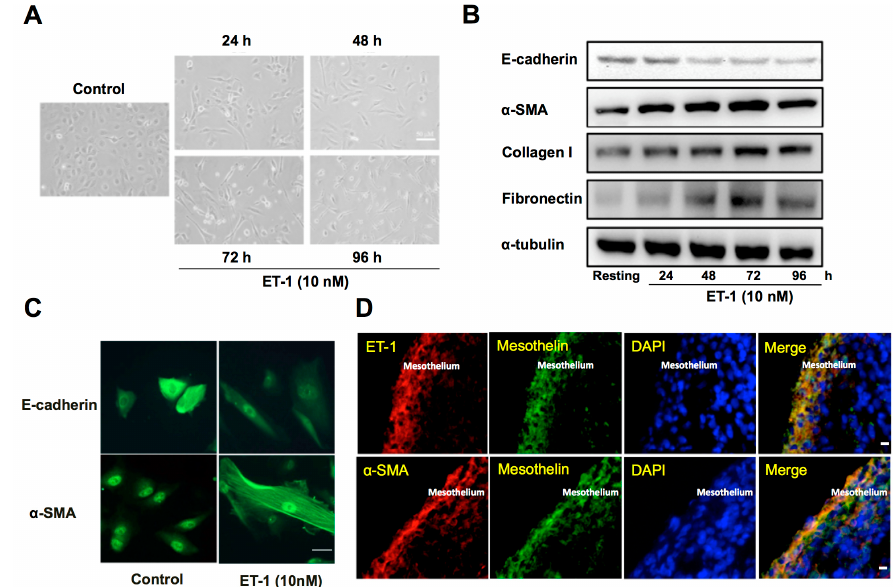
Figure 4. ET ‐ 1 induces MMT and ECM synthesis in primary human PMCs and associates with α‐ SMA expression in pleural mesothelium of patients with TBPE. ( A ) Primary human PMCs were treated with or without (control) ET ‐ 1 for 96 h. Phenotypic change (transition from mesothelial toward mesenchymal phenotype) was evaluated by phase contrast microscopy. Scale bar, 50 μ m. ( B ) Primary human PMCs were treated with ET ‐ 1 (10 nM) for the indicated times, and E ‐ cadherin, α‐ SMA, collagen I and fibronectin were analyzed by Western blotting. Results are representative of three independent experiments. ( C ) Primary human PMCs were treated with or without (control) ET ‐ 1 for 72 h, and phenotypic change and expression for E ‐ cadherin and α‐ SMA were evaluated by immunofluorescence microscopy. Scale bar, 20 μ m. ( D ) Immunofluorescence staining for ET ‐ 1 (red) or α‐ SMA (red) and mesothelin (green) in PMCs was performed on paraffin ‐ embedded pleural biopsy specimens from patients with TBPE and observed by confocal microscopy. Cells were also co ‐ stained with DAPI to visualize the nuclei (blue). Scale bar, 50 μ m. MMT, mesothelial mesenchymal transition; ECM, extracellular matrix; PMC, pleural mesothelial cell; α‐ SMA, α‐ smooth muscle actin; DAPI, 4’, 6-diamidino-2-